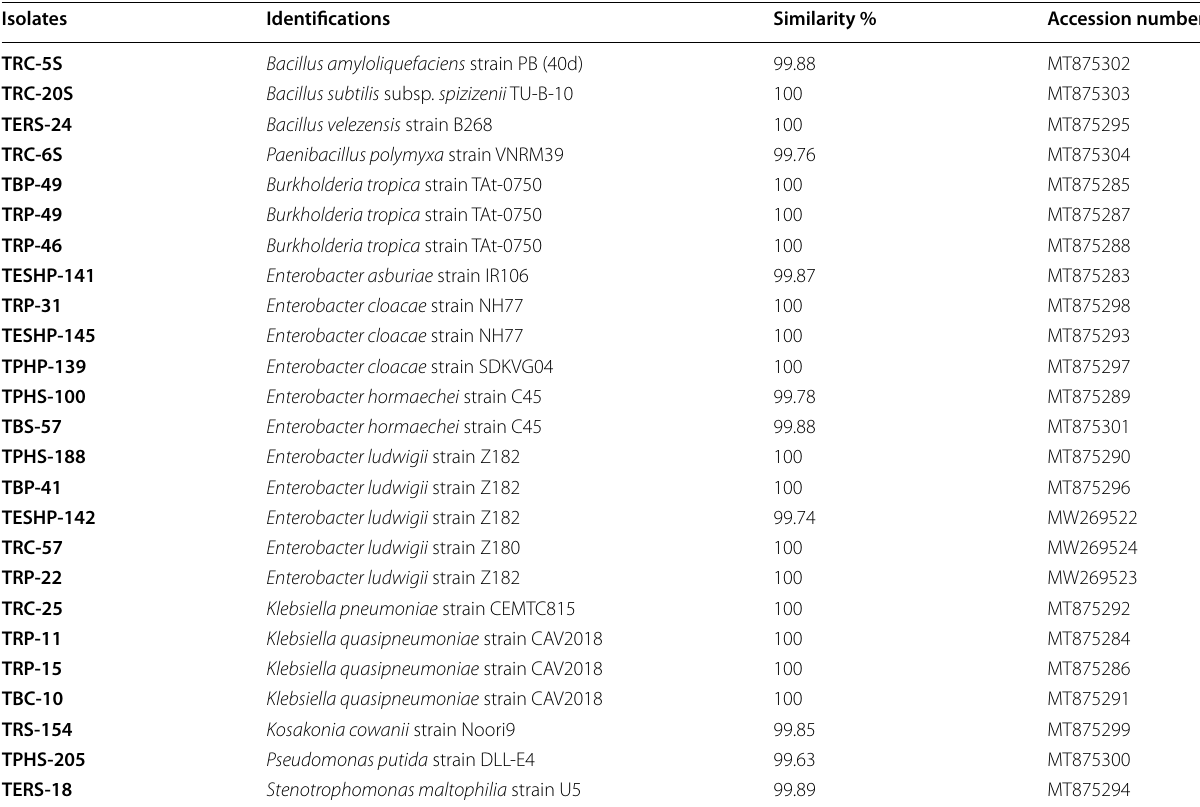
Table 5 Sequence analysis of 16S rRNA gene of PGPR isolated from different tomato plant spheres and soil types